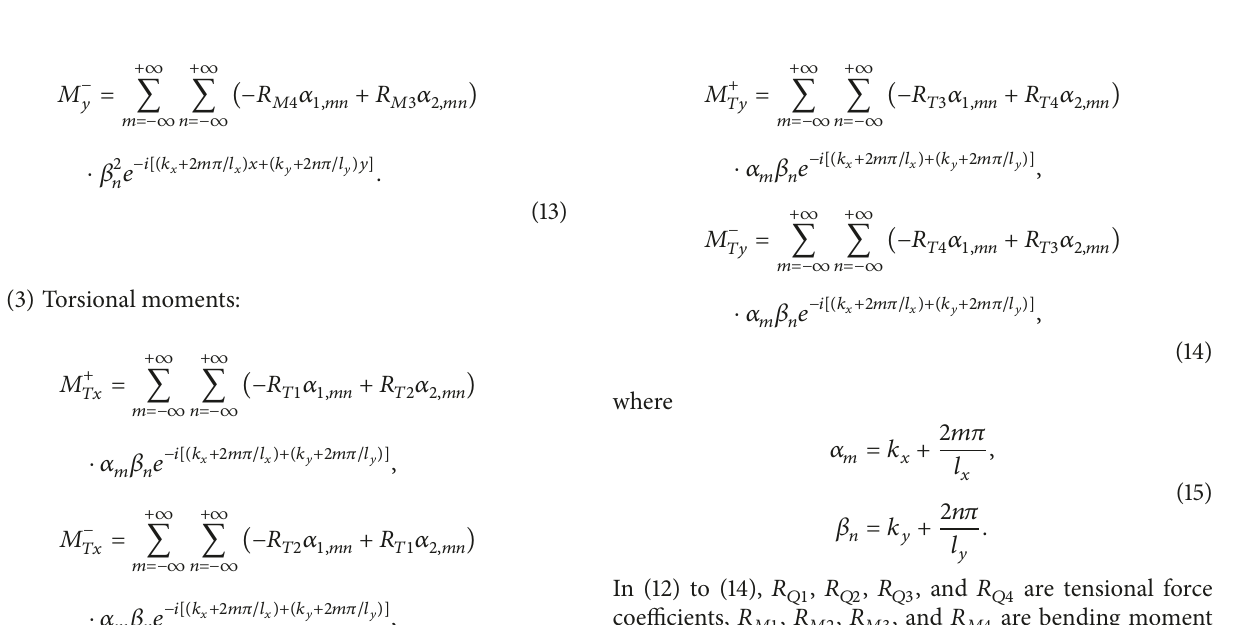
Figure5:Conventionfortensionalforces,bendingmoments,andtorsionalmomentsbetweenbottomfacesheetand(a) 𝑥 -wiseand(b) 𝑦 -wise